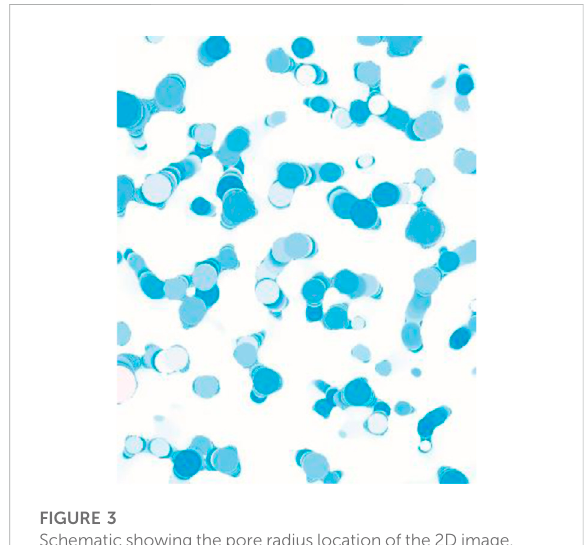
FIGURE 3 Schematic showing the pore radius location of the 2D image, pure white shown in solid pixels, and different depths of blue represent the process of locating the pore